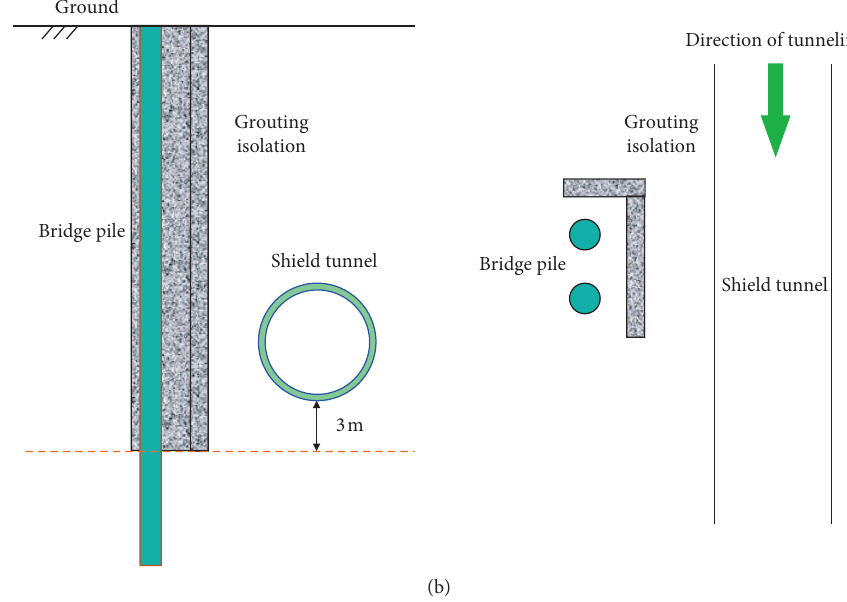
Figure 19: Grouting scheme comparison: (a) traditional parallel grouting; (b) L-type optimized grouting.